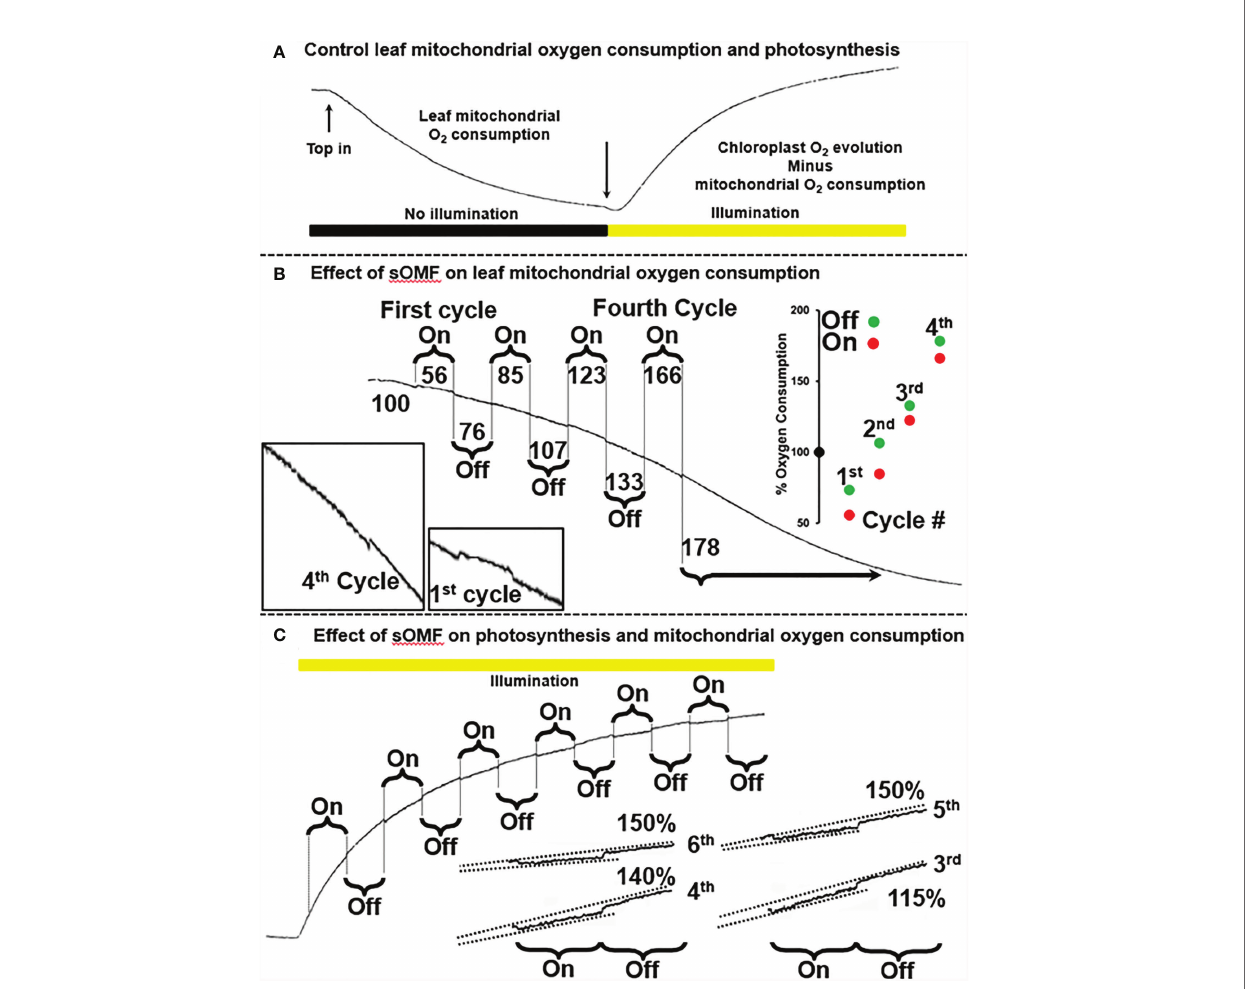
FIGURE 6 | Spinning magnetic fi eld effects on lemon tree leaf. (A) A classic O 2 -electrode trace showing the consumption of O 2 by plant leaf mitochondria, prior to illumination. After illumination photosynthesis is active and the O 2 levels rise. (B) Magnetic stimulation causes a partial inhibition of plant mitochondrial fl ux as well as mild uncoupling, and these effects are cumulative after repeated cycles of stimulation. (C) Magnetic stimulation causes a partial inhibition of